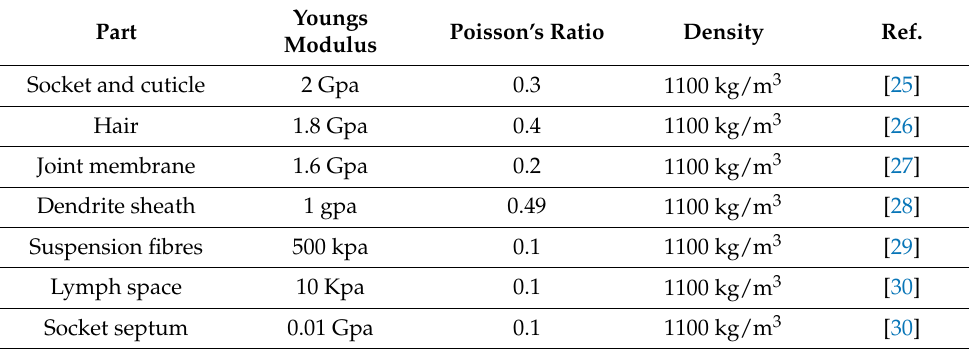
Table 1. Sensilla part mechanical